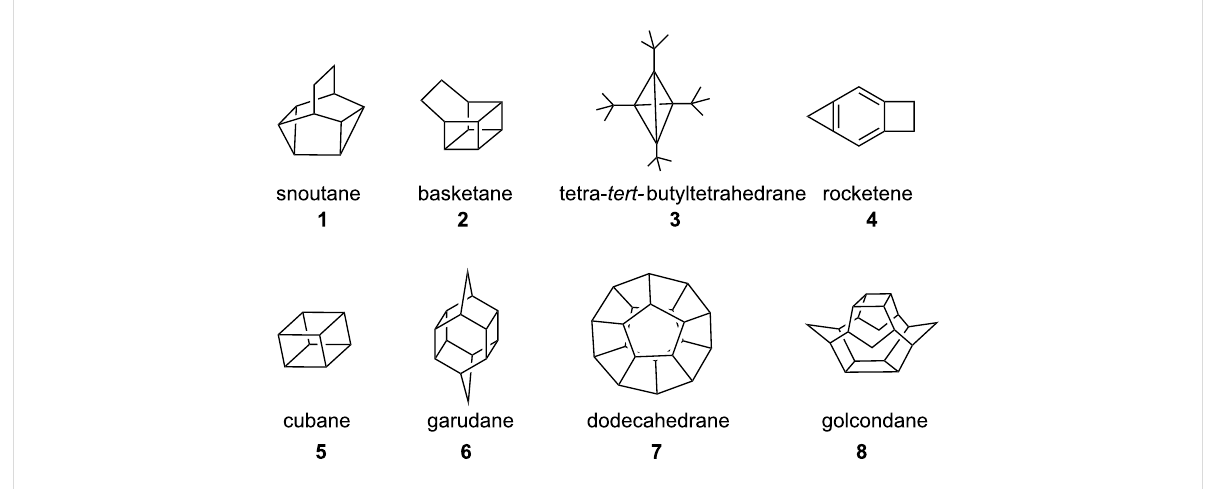
Figure 1: Selected theoretically interesting molecules.